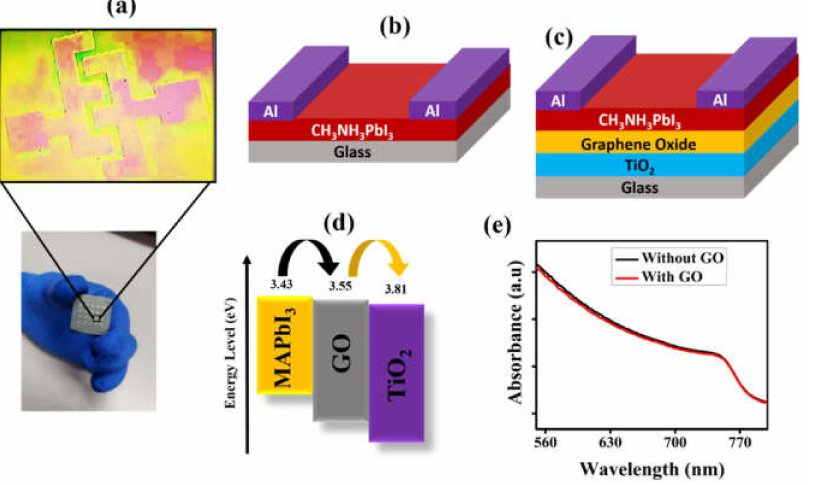
Figure 3. ( a ) Optical image of the device showing the metal contacts. Schematic cross section of ( b ) the single layer (without GO) device, and ( c ) the trilayer (with GO) device. ( d ) Schematic energy level diagram of the trilayer structure. ( e ) Absorbance spectra of perovskite (with and without GO)